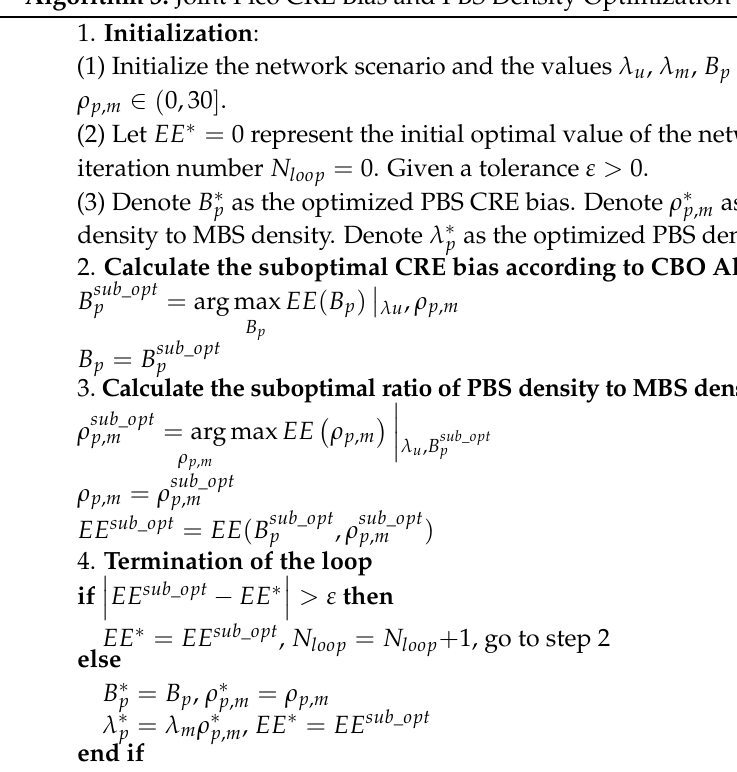
Algorithm 3: Joint Pico CRE Bias and PBS Density Optimization (JBPDO)